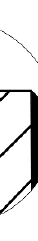
Figure 3. The illustration of the gaps between the disk and the limit stop.